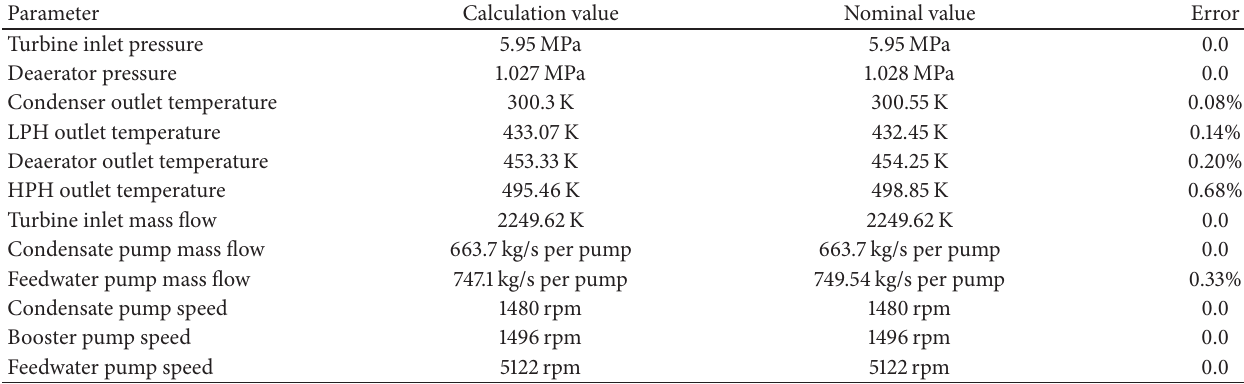
Table 1: Validation of steady-state parameters.